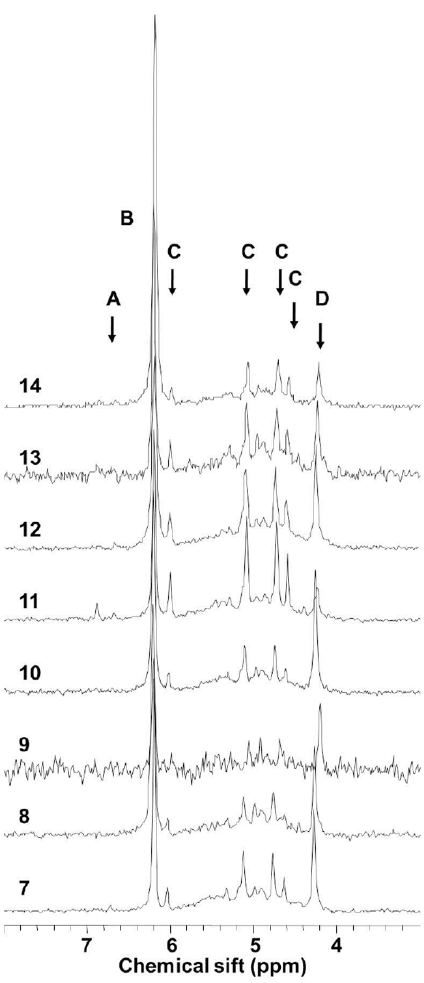
Figure 5. Region 8 to 3ppm of group B (site 7 to 18) wetlands NMR spectra and peak assignments for (a) neo - and d- chiro -inositol hex- akisphosphate, (b) orthophosphate, (c) myo -inositol hexakisphos- phate, and (d) scyllo -inositol